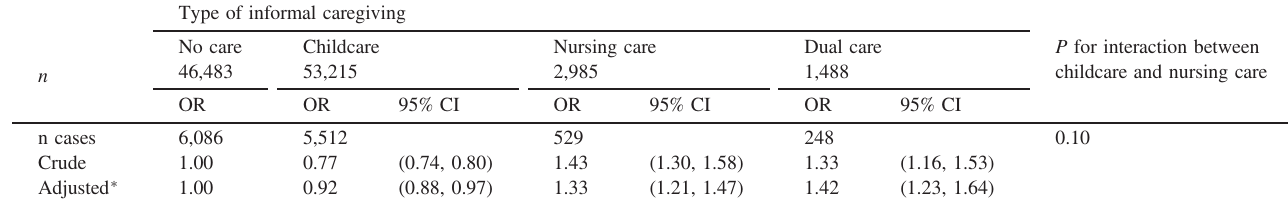
Table 2. Odds ratios for self-rated poor health associated with the types of informal caregiving among ever-married Japanese women aged 20 – 59 years